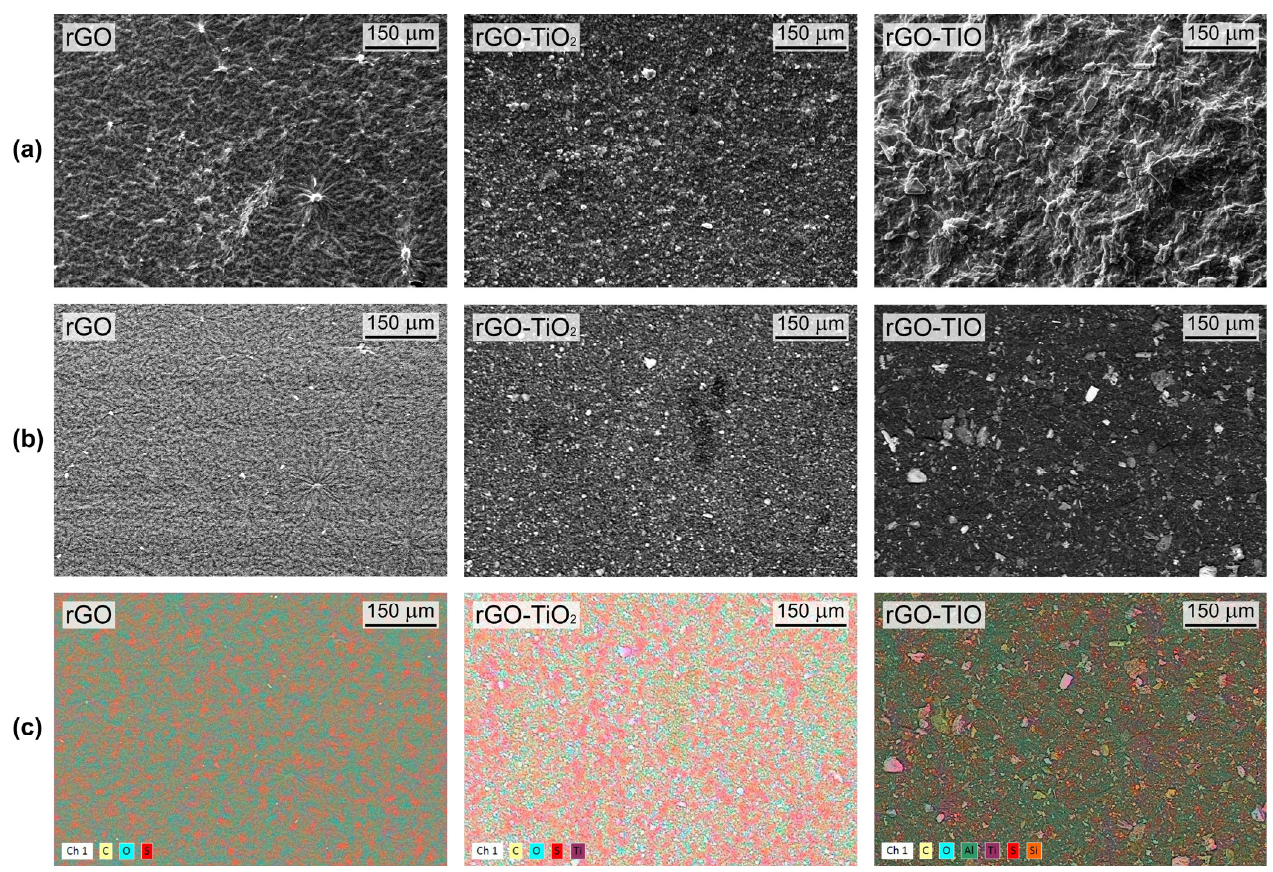
Figure 5. SEM pictures of pristine rGO ( left ), rGO–TiO 2 ( middle ), and rGO–TIO ( right ) membranes: ( a ) secondary electrons, ( b ) backscattered electrons, and ( c ) elements distribution.